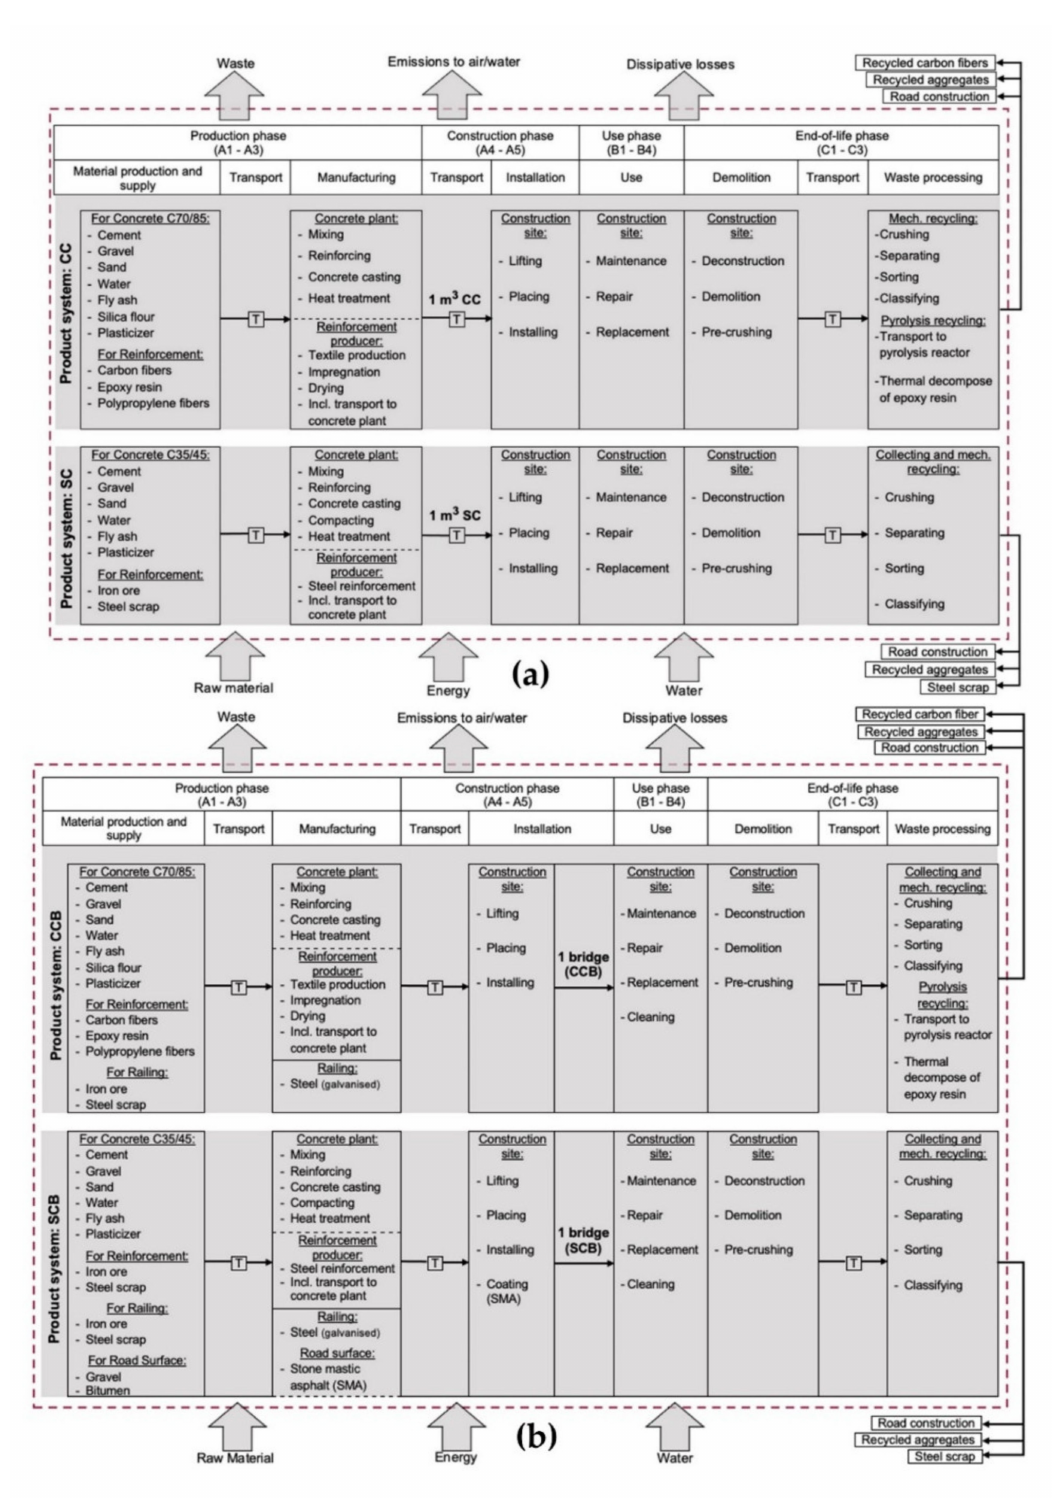
Figure 1. System boundaries of the life cycle assessment of ( a ) carbon concrete (CC), steel-reinforced concrete (SC) and ( b ) carbon concrete bridge (CCB), steel-reinforced concrete bridge (SCB) based on DIN EN 15804